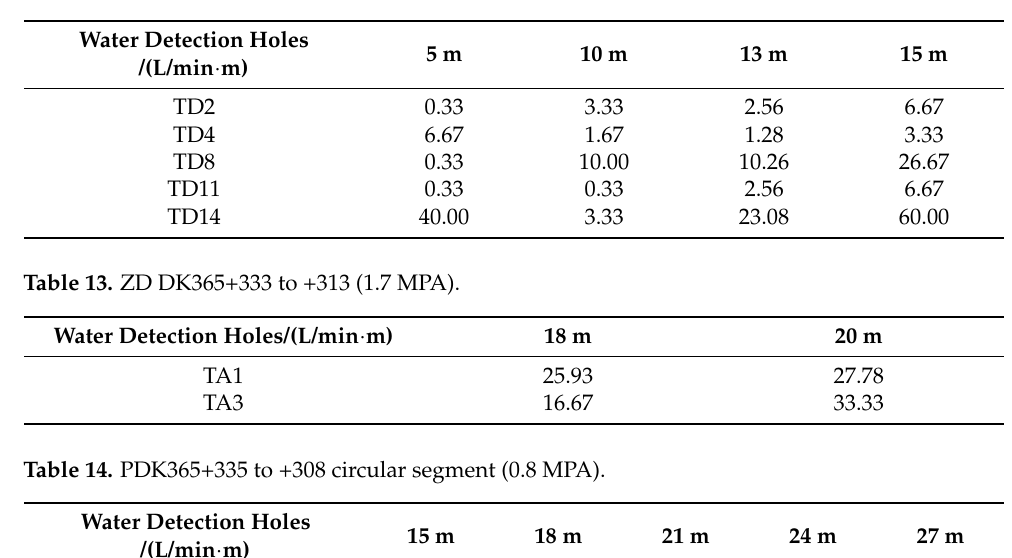
Table 12. PDK365+327.5~+312.5 Circulation section (0.9 MPA).